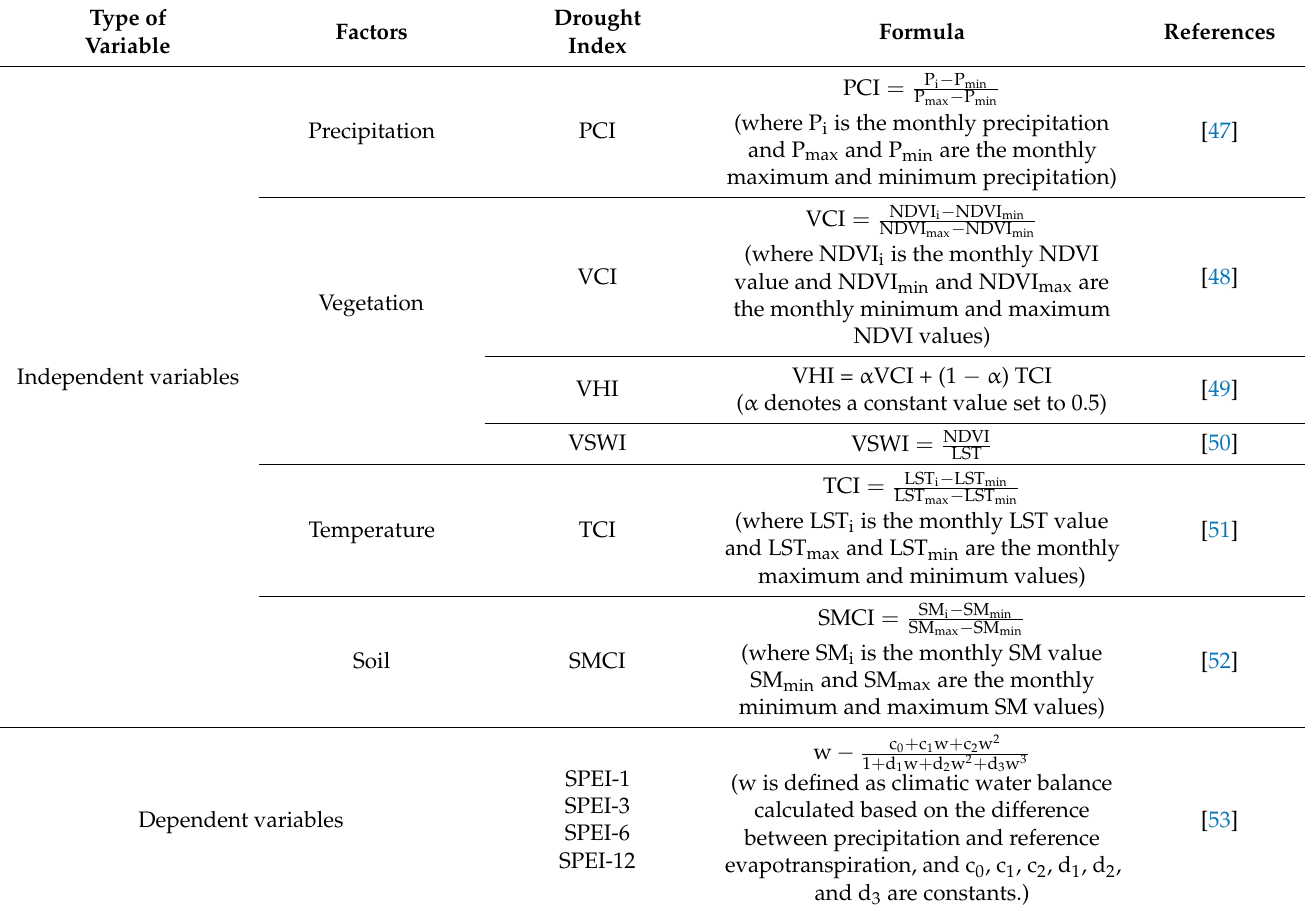
Table 2. Descriptions of the input